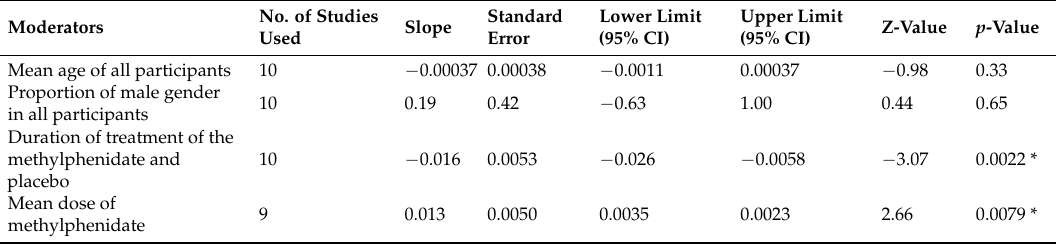
Figure 4. Forest plot and subgroup analysis on post- versus pre-treatment systolic blood pressure (SBP) between placebo and methylphenidate groups. Table 4. Meta-regression analysis that explored the source of heterogeneity on the post- vs. pre-treatment SBP between placebo and methylphenidate groups.